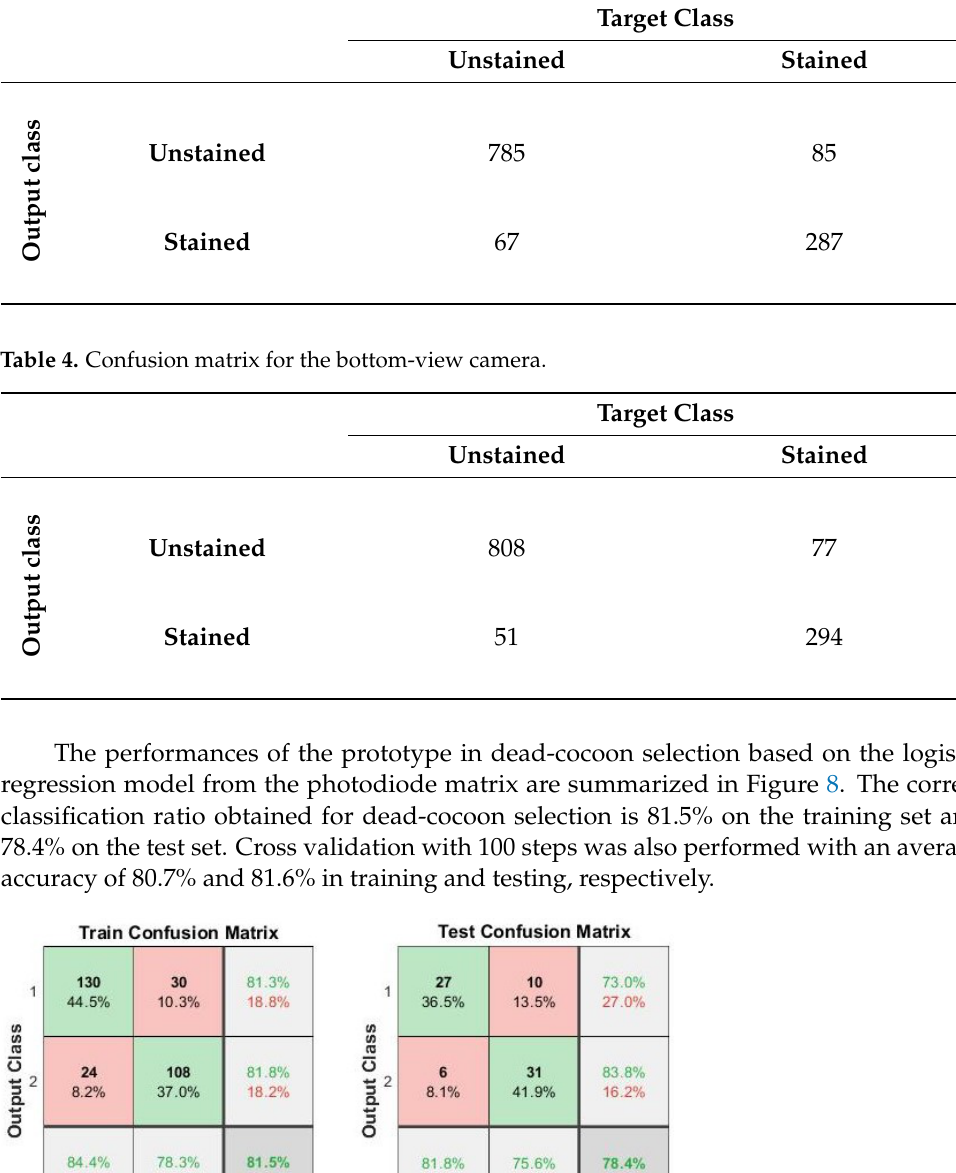
Table 3. Confusion matrix for the top-view camera.